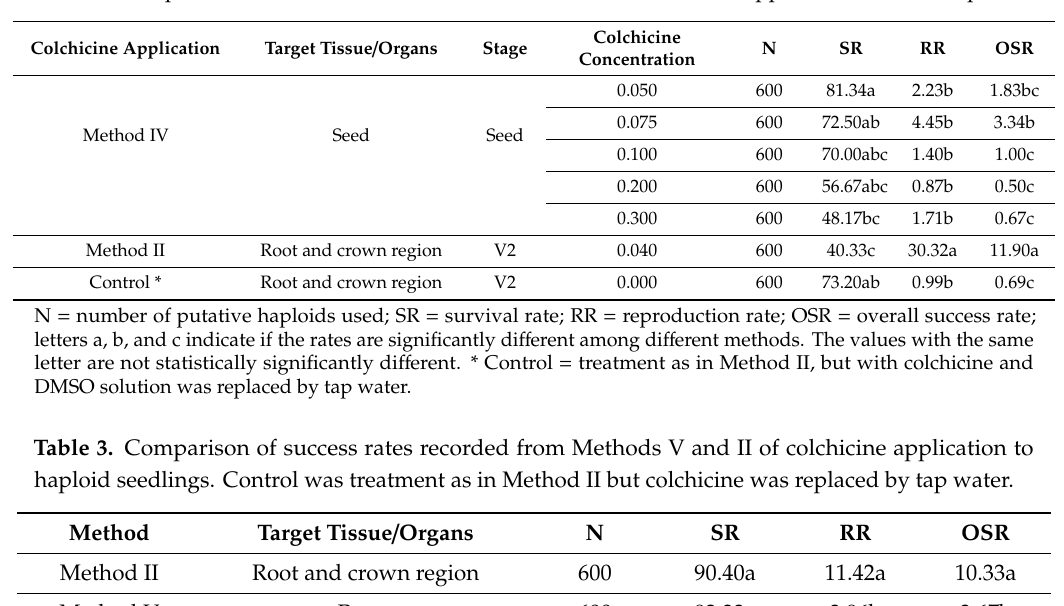
Table 2. Comparison of success rates from Methods IV and II of colchicine application to maize haploids.